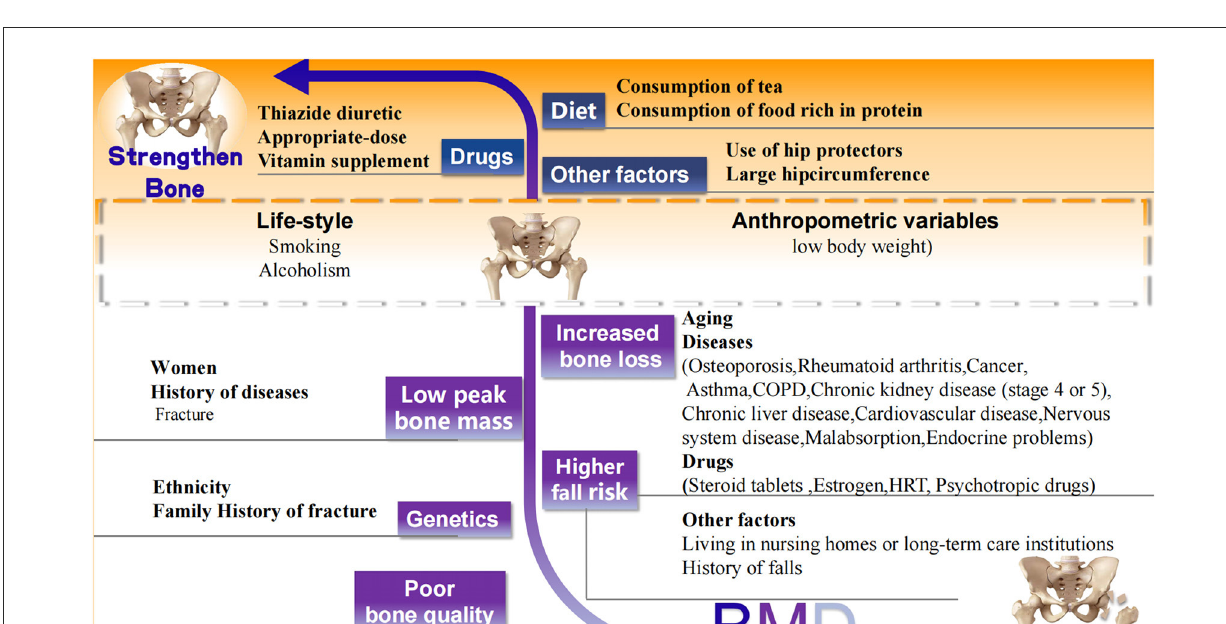
relative improvement of healthcare service in urban areas with